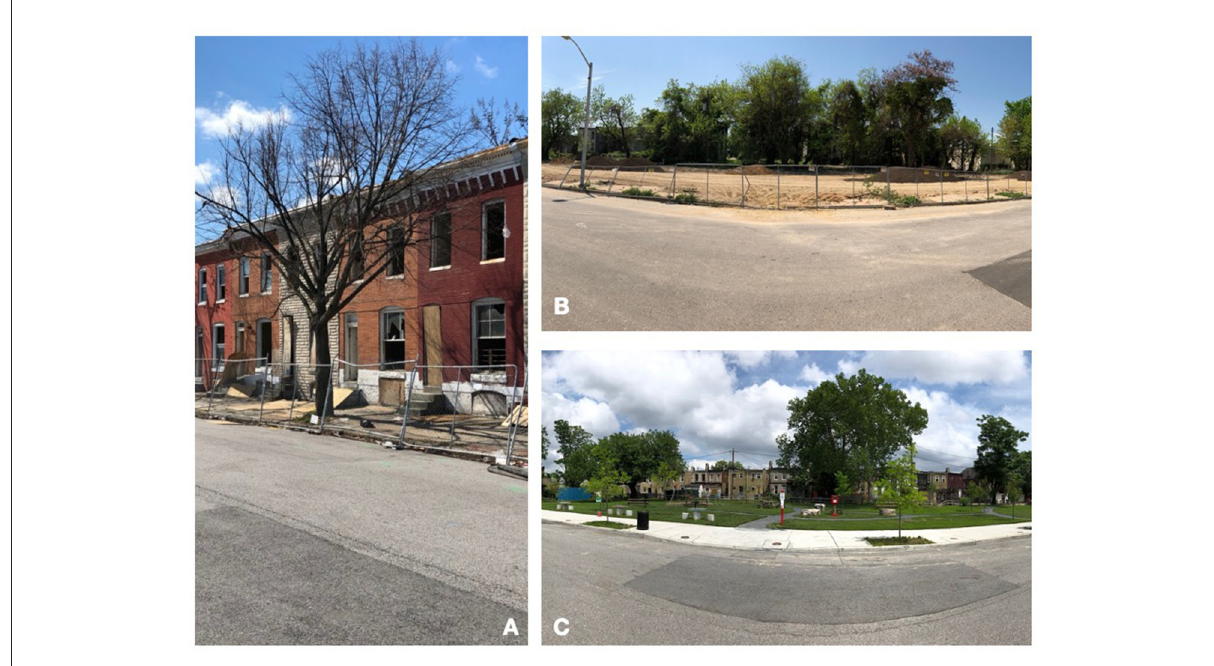
FIGURE7 Vacant buildings, deconstruction, and revival for McKean Park. (Photos: J. Morgan Grove, USDA Forest Service). Vacant buildings (A) , deconstruction (B) , and revival (C) for McKean